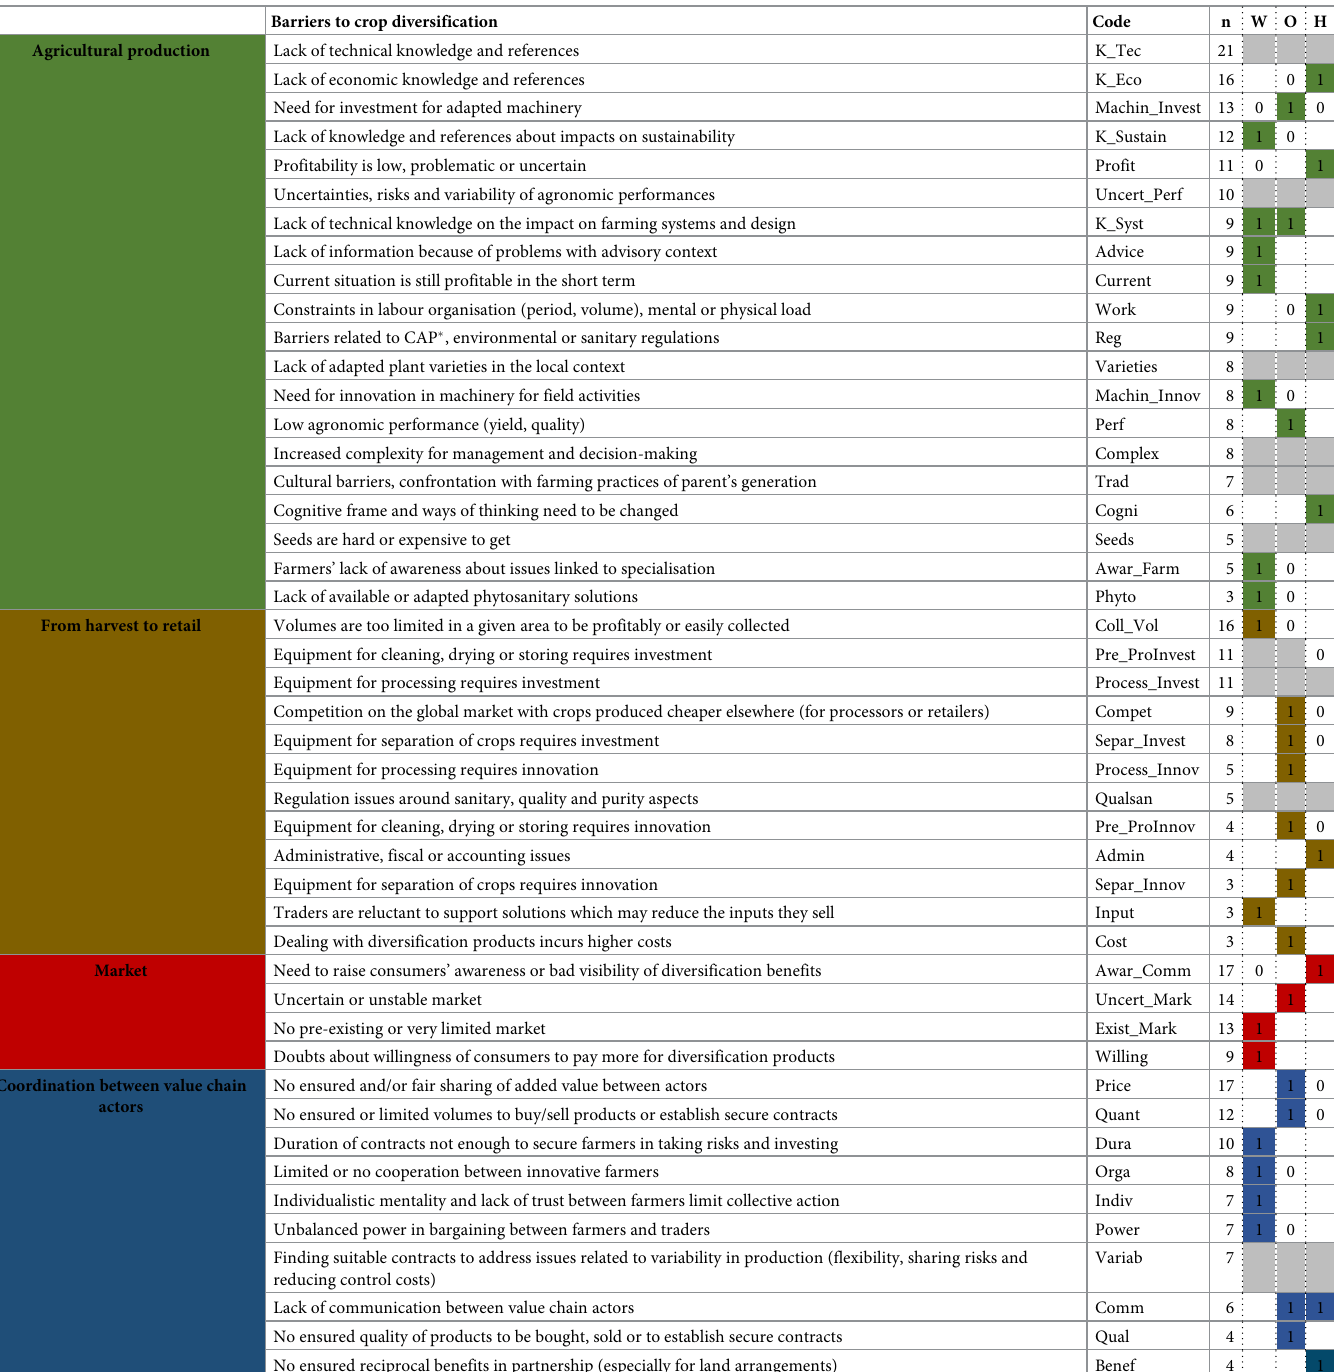
Table 2. Occurrence of barriers to diversification in the 25 case studies and their links to the ideal-types of food system innovation